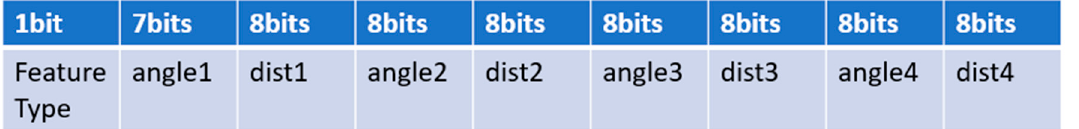
Figure 7. The 64-bit orientation invariant description vector with the first bit used to define the macro-feature type.